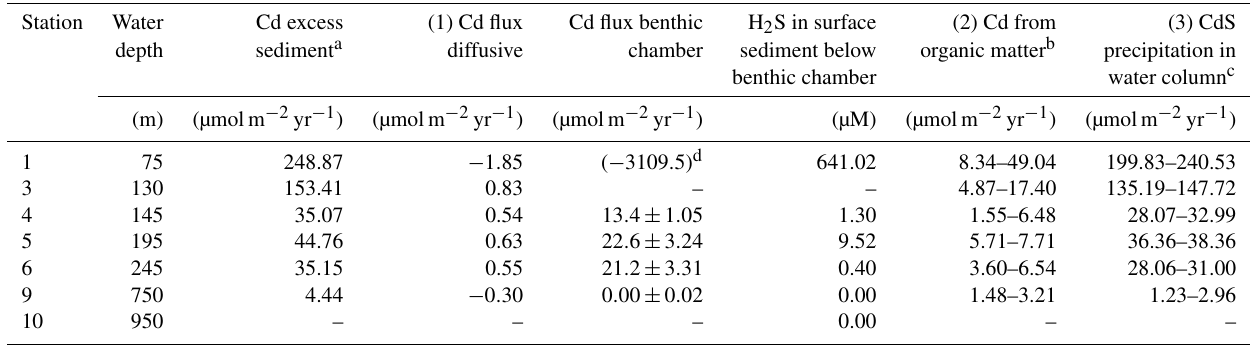
Table 3. Comparison of sedimentary Cd excess compared with the lithogenic background and the contribution of Cd delivery to the sediment via different pathways: (1) diffusion across the sediment–water interface and cadmium sulfide (CdS) precipitation within the sediment; (2) Cd incorporation by phytoplankton and delivery to the sediment with organic matter; (3) CdS precipitation in the water column and particulate delivery to the